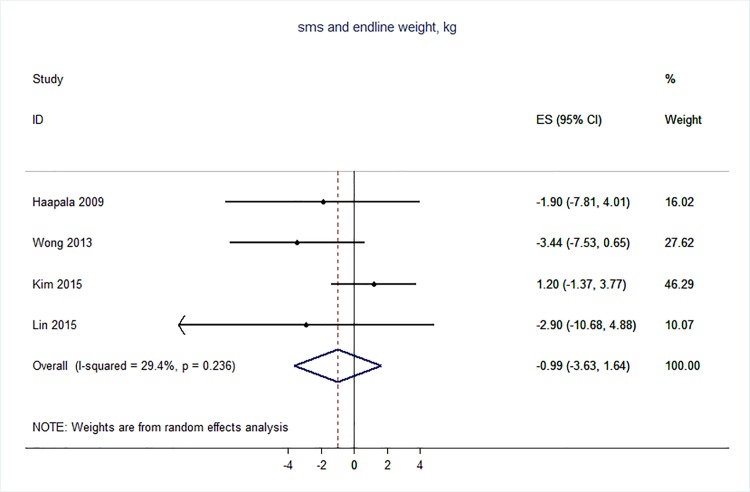
Physical activity and diet interventions using SMS function–weight endpoint (kg).